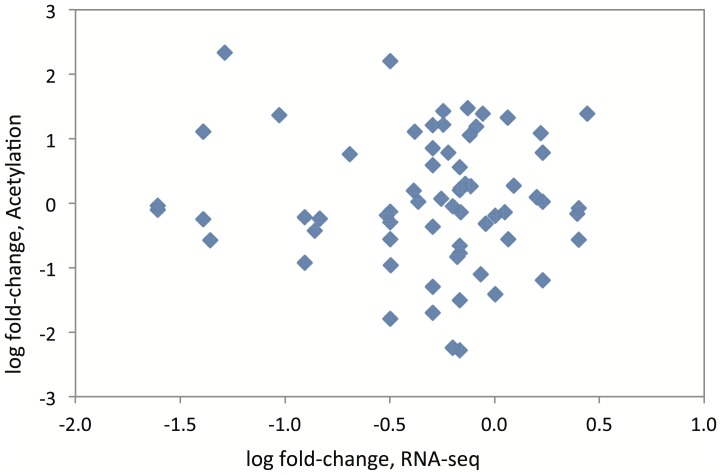
Scatter-plot of log fold-change of lysine acetylation and fold-change of RNA-sequencing.Each point represents one protein/transcript. y-axis: log2 of fold change in protein acetylation between GK and BN rats. x-axis: log2 of fold-change in mRNA sequence counts between GK and BN rats.